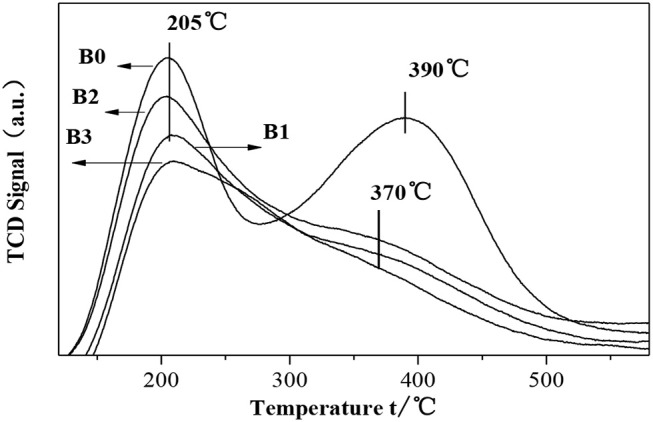
NH3-TPD spectra of parent ZSM-5 (B0) and hierarchically ZSM-5 (B1, B2, B3).